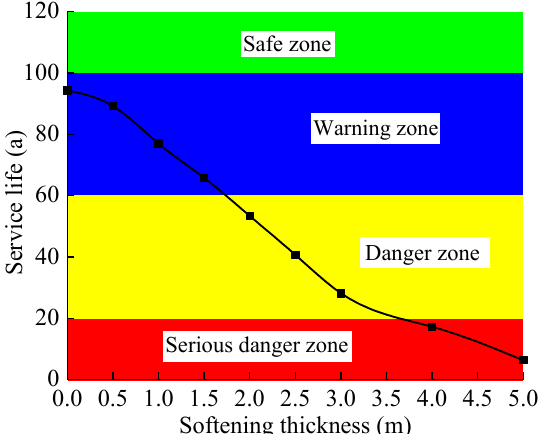
Figure 18. Service life of base structure with different softening thicknesses.